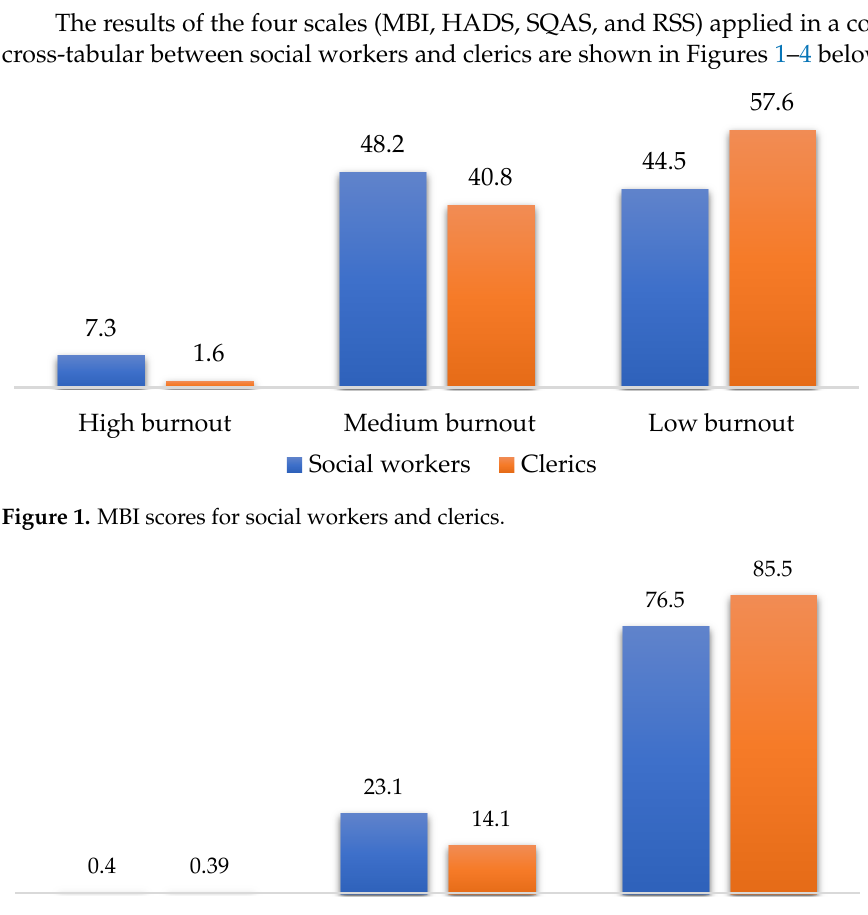
Figure 2. HADS scores for social workers and clerics.